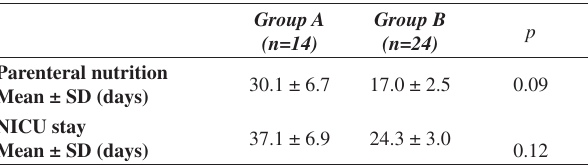
Table 2 - Total enteral feeding and NICU length of stay